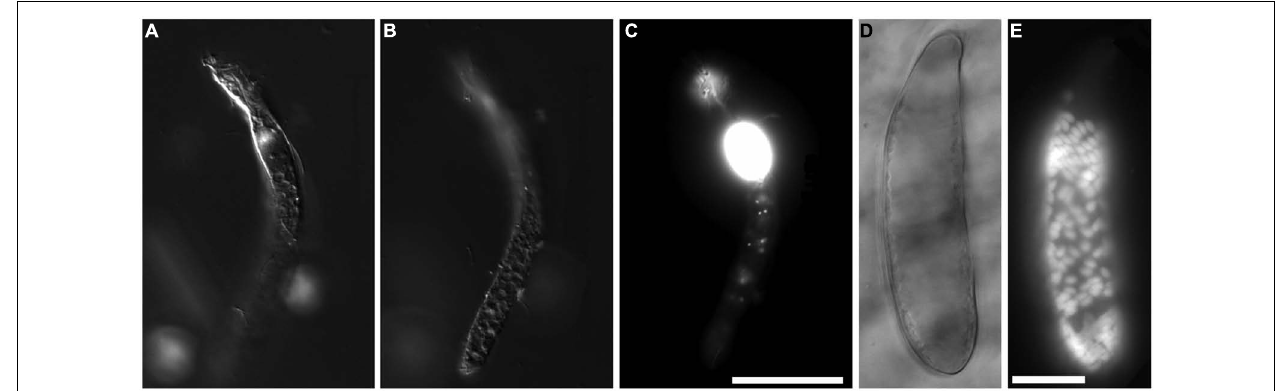
(D,E) Paired images showing DIC (D) and epifluorescence (E) of protist from 610 c9 (lower halocline). Note lack of obvious single large